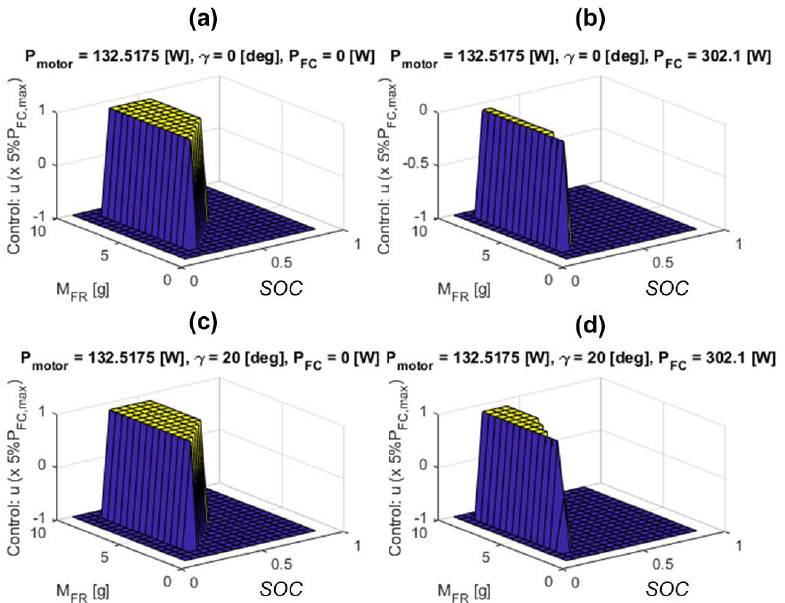
Figure 6. A cross-section of the control policy in the endurance maximization problem for P M = 132.52 W and with ( a ) γ = 0 deg, P FC = 0 W, ( b ) γ = 0 deg, P FC = 302.1 W, ( c ) γ = 20 deg, P FC = 0 W, and ( d ) γ = 20 deg, P FC = 302.1 W.